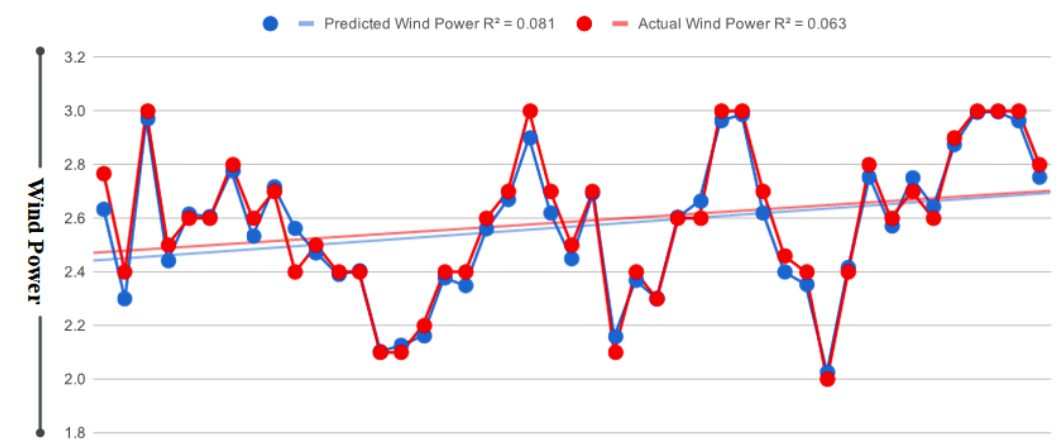
Figure 5. Forecasted and Actual Power (kW) outcomes for Windfarm 1 via the Proposed Methodology.